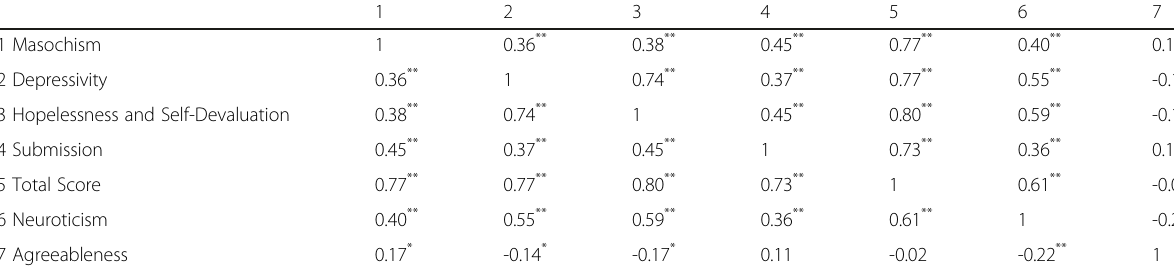
Table 2 Total score, factor and NEO-PI-R dimension correlation